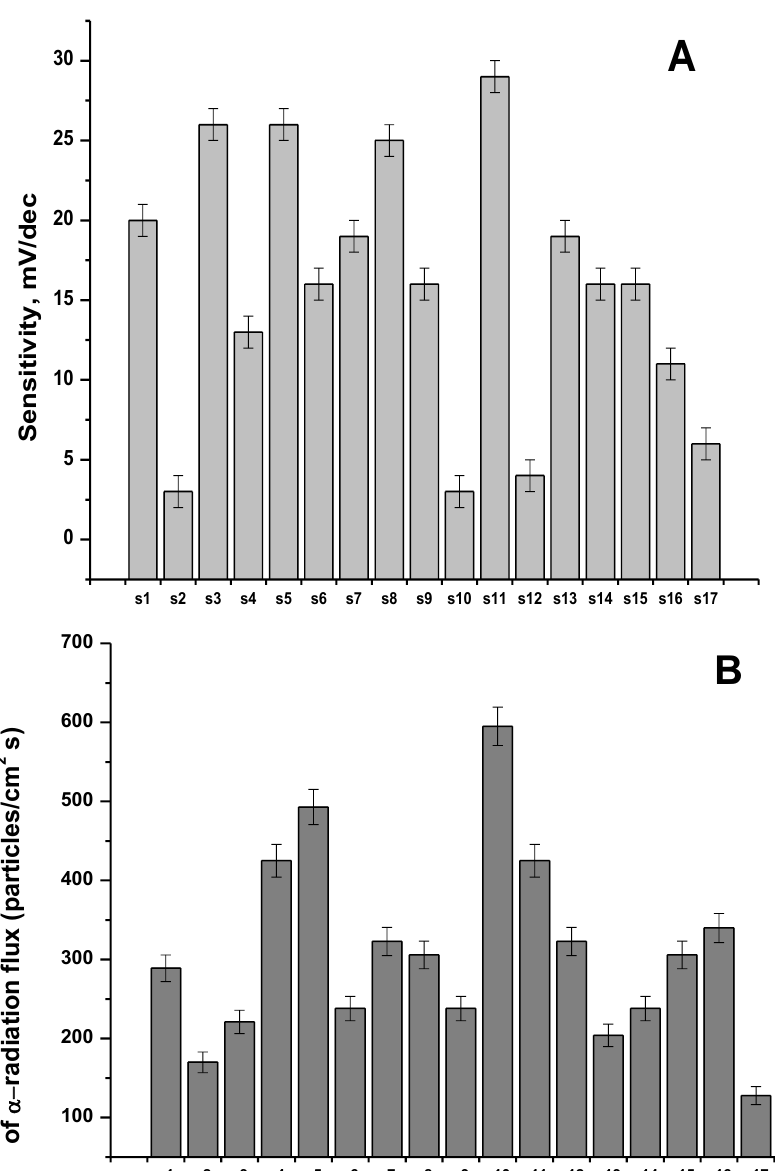
Figure 1. Typical potentiometric response curves in Pu 4+ aqueous solutions with 1.5 M HNO 3 . The presented EMF values are determined with ± 0.1 mV precision.